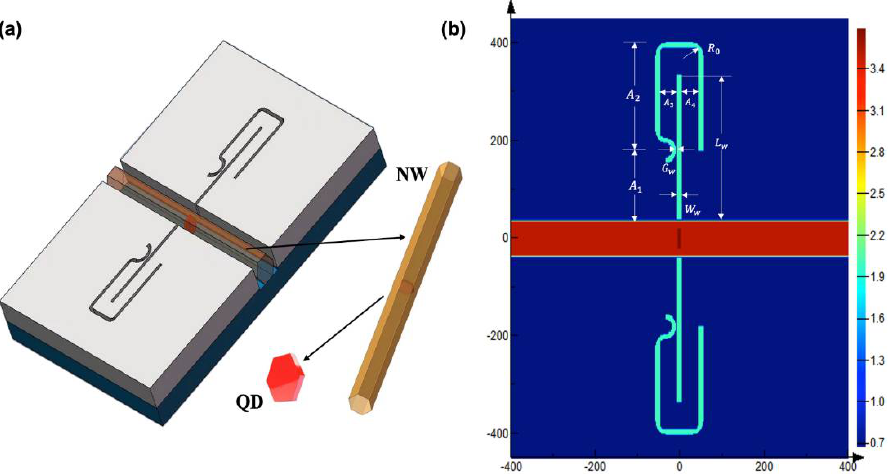
Figure 1. ( a ) Schematic diagram of the InGaAs/GaAs QDNW heterostructure coupled with the MIM waveguide. ( b ) Different parameters of resonant cavity.